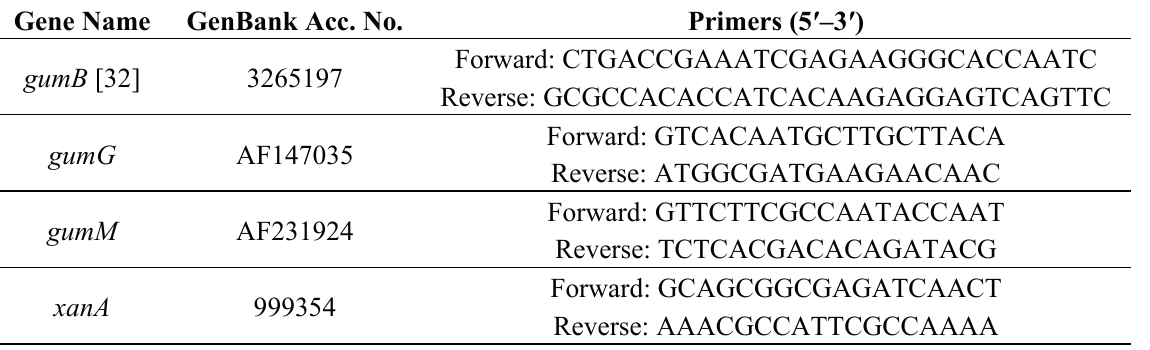
Table 5. Groups of RT-qPCR primers used to amplify gene-specific